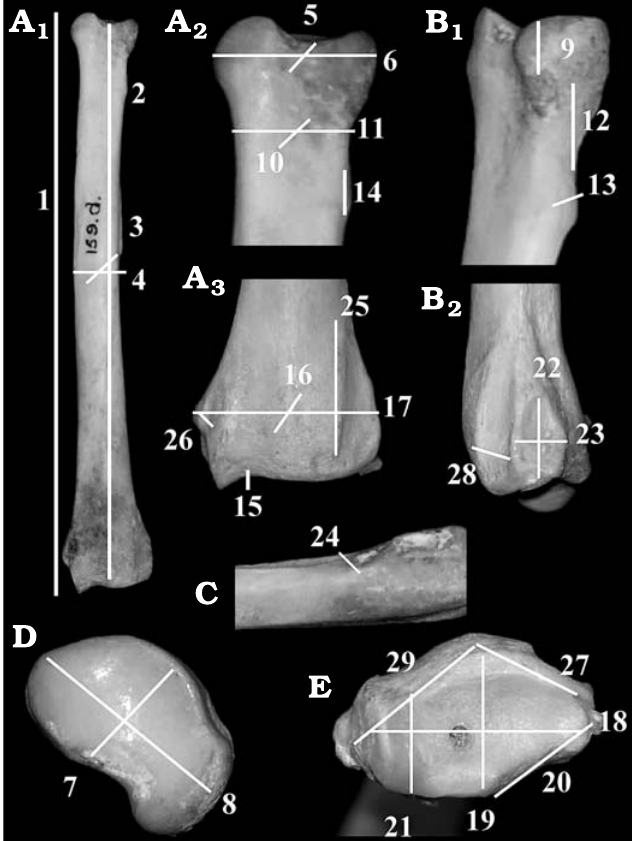
Fig. 1. Measurement scheme for the canid radius, illustrated using a left radius of Cuon alpinus , NHMUK M1888.2.5.22_159.d, in posterior view (A 1 ), proximal (A 2 ) and distal (A 3 ) end; lateral view proximal (B 1 ) and distal (B 2 ) end; distal view of radius lower extremity (C), proximal (D) and distal (E) views of radius epiphyses. Not to scale. Explanation of radial measurements 1–29 in Table